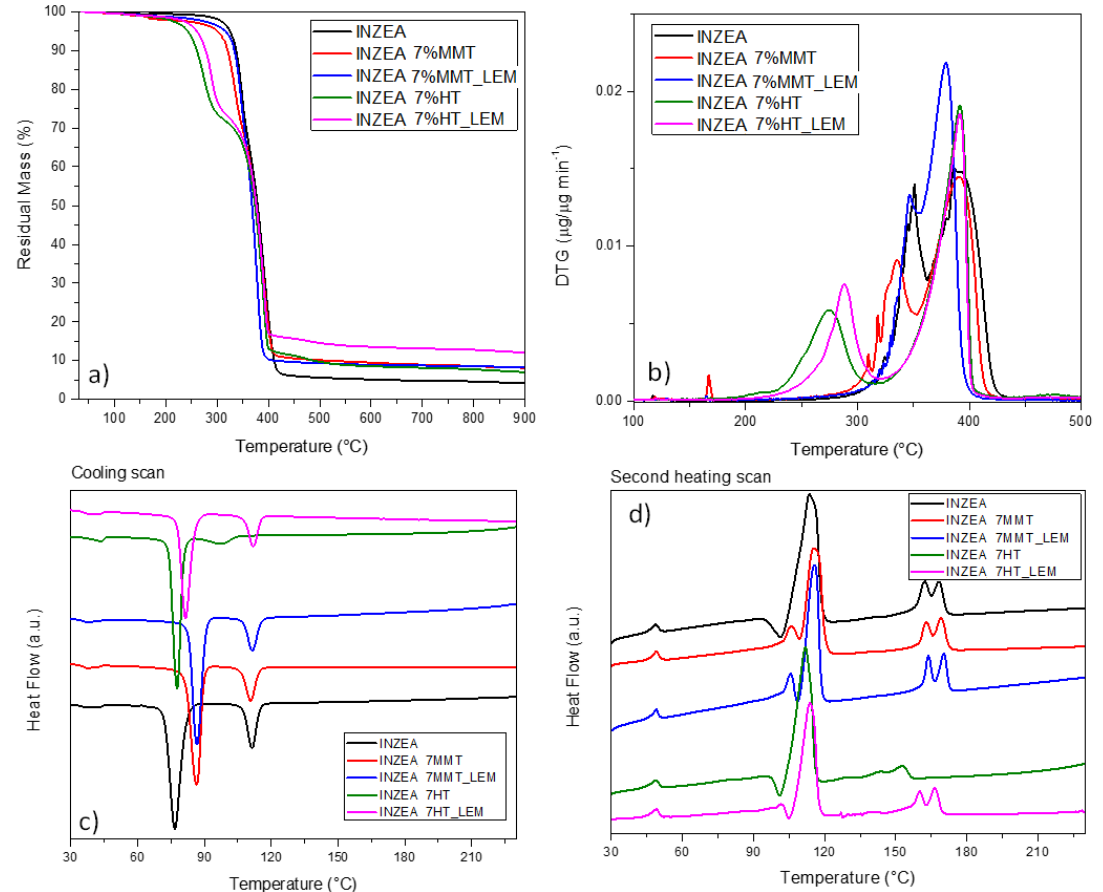
Figure 6. TG ( a ) and DTG ( b ) profiles and DSC curves, cooling ( c ) and 2nd heating ( d ) for INZEA containing MMT and HT functionalized with lemon hybrid pigments.